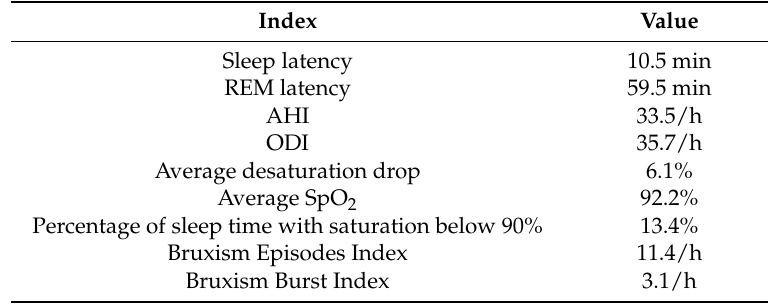
Table 3. Polysomnography